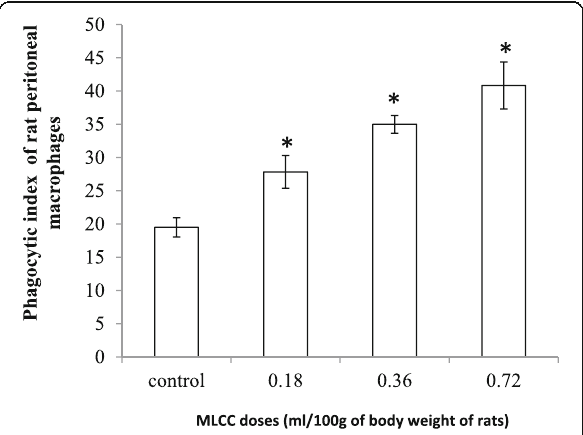
Fig. 2 Plasma cytokines - IFN γ , TNF α , IL-6 and IL-10 levels of rats orally gavaged with the MLCC. Results are expressed as Mean ± SEM for the number of animals used ( n = 6/group). * p < 0.05 were considered significant when compared with the control (Mann Whitney U test)